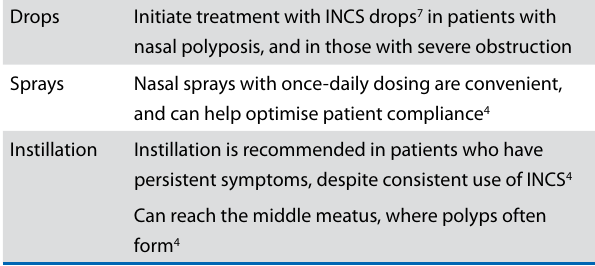
Table II: Choosing an intranasal corticosteroid